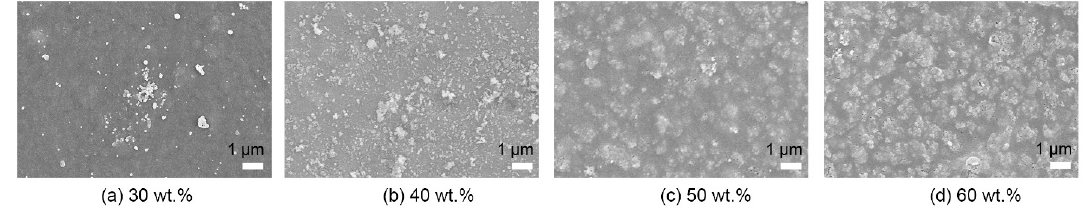
Figure 6. Composite materials with different ZIF-8 loading (nanosized crystals). DMF was used as the solvent.